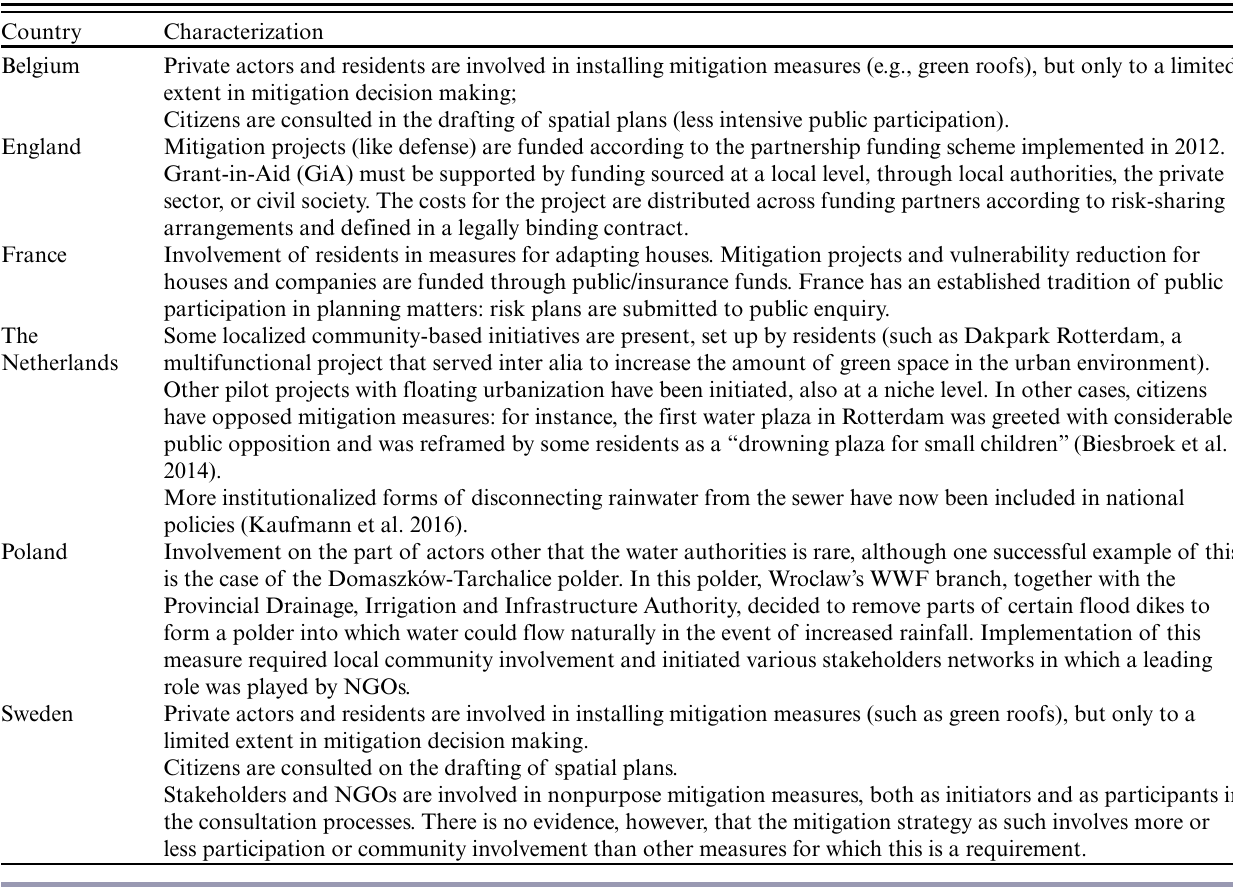
Table 4 . Characterization of the six researched countries on the degree in which private actors, including citizens, are involved in the flood mitigation